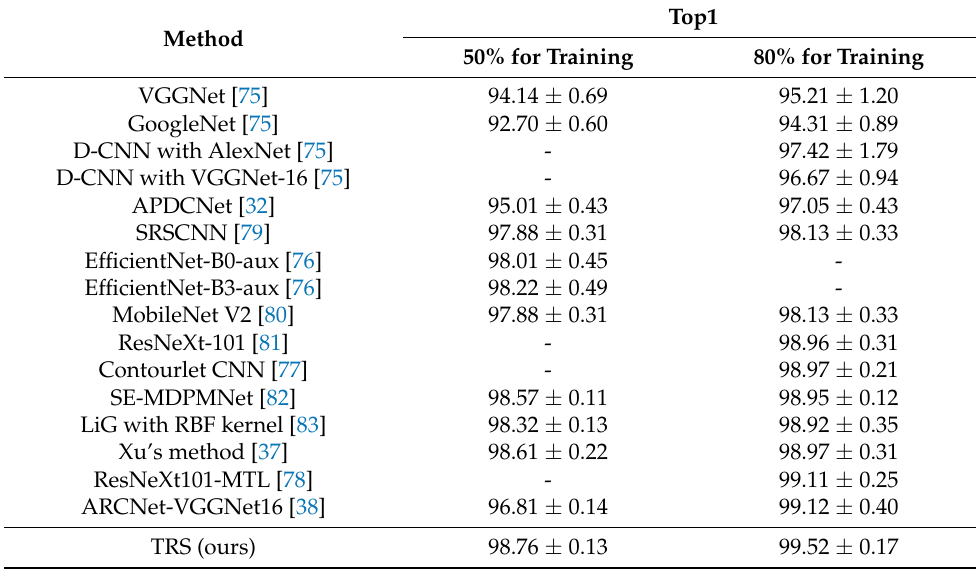
Table 3. Classification accuracy on UC-Merced Dataset.